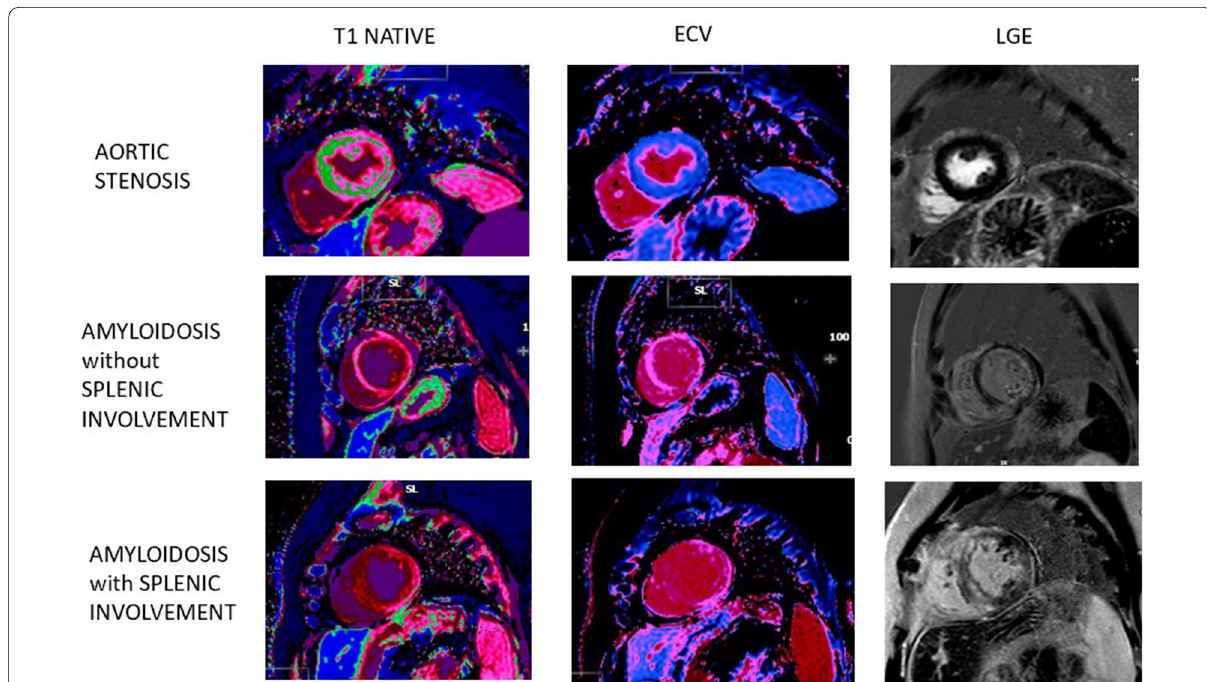
Fig. 4 Table presenting the differences in myocardial and splenic values in a patient with Aortic Stenosis, and patients with Cardiac Amyloidosis with and without splenic involvement, in T1 NATIVE map and ECV map, in correspondence to late gadolinium enhancement (LGE)